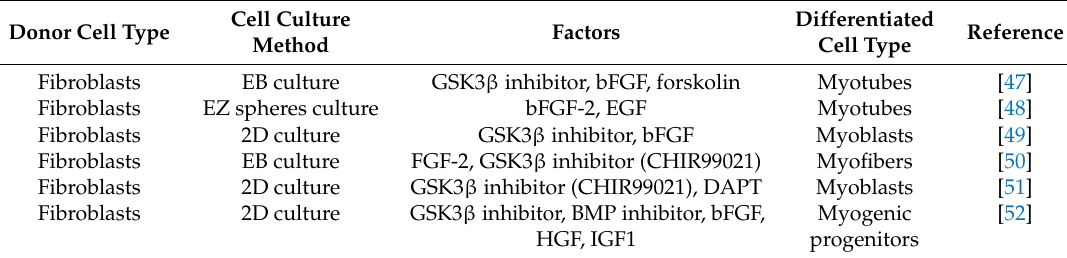
Table 3. Transgene-free myogenic induction of